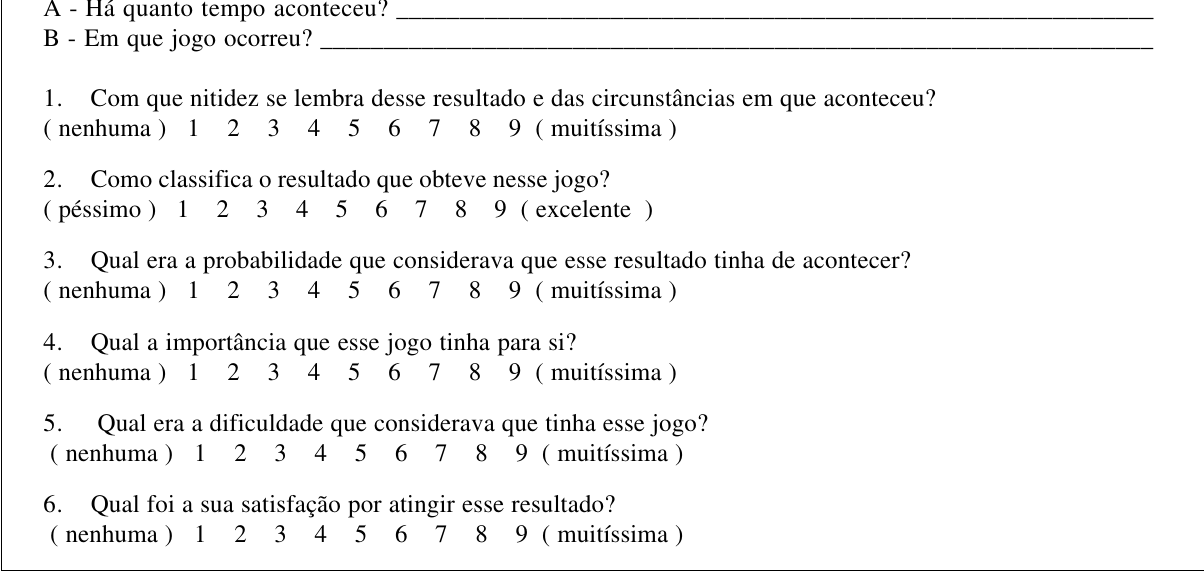
Figura 1. Avaliação do jogo e avaliação do melhor e pior resultado obtido. Na avaliação das atribuições causais foi utilizada uma versão traduzida e adaptada para a população